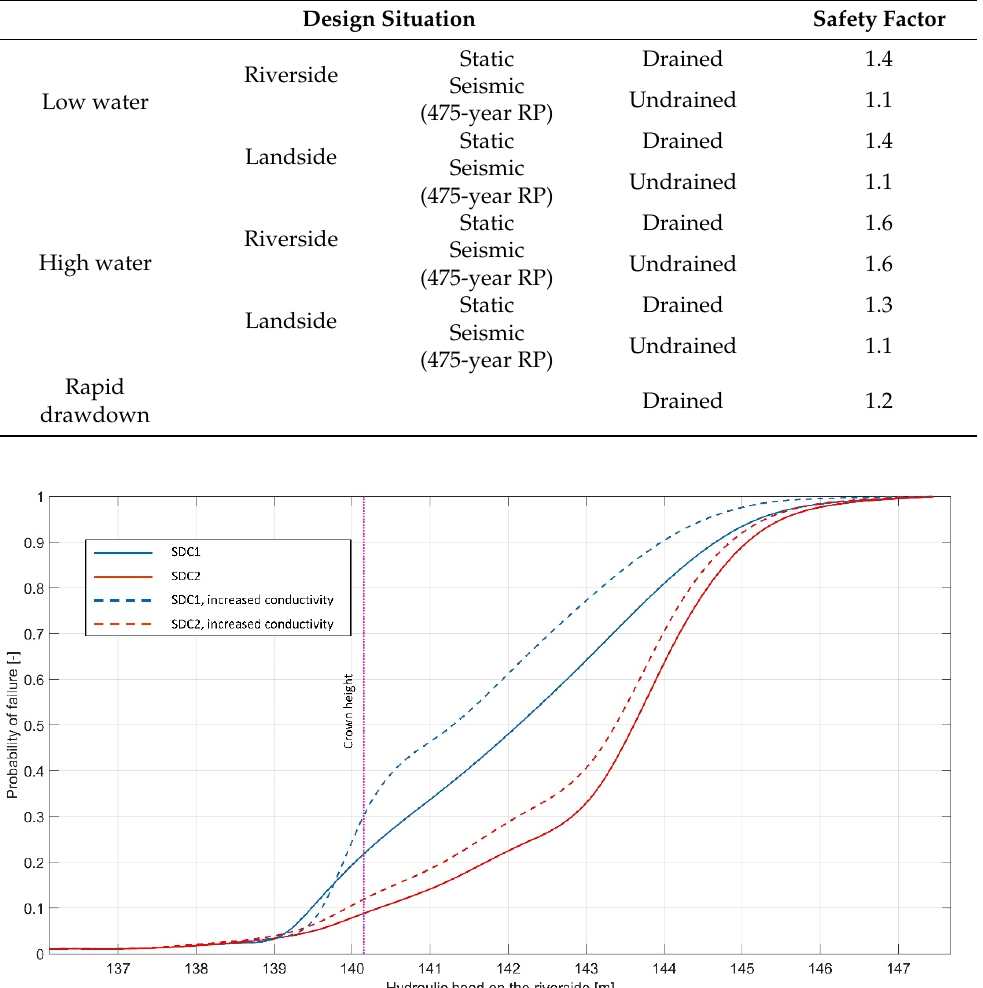
Figure 7. Fragility curves for landside slope stability with respect to varying hydraulic conductivities.